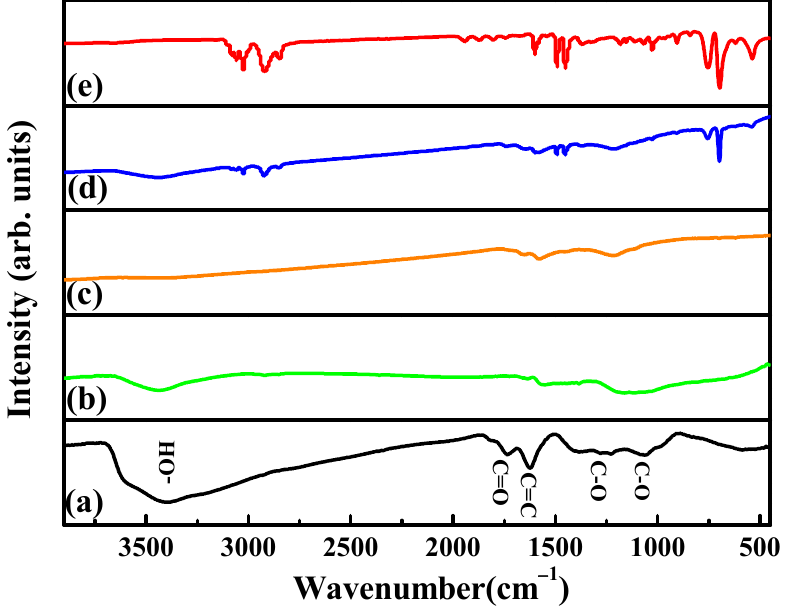
Figure 6. FTIR spectra of ( a ) GO, ( b ) RGO, ( c ) MRGO-HS, ( d ) PS beads, and ( e ) PS/GO core–shell.